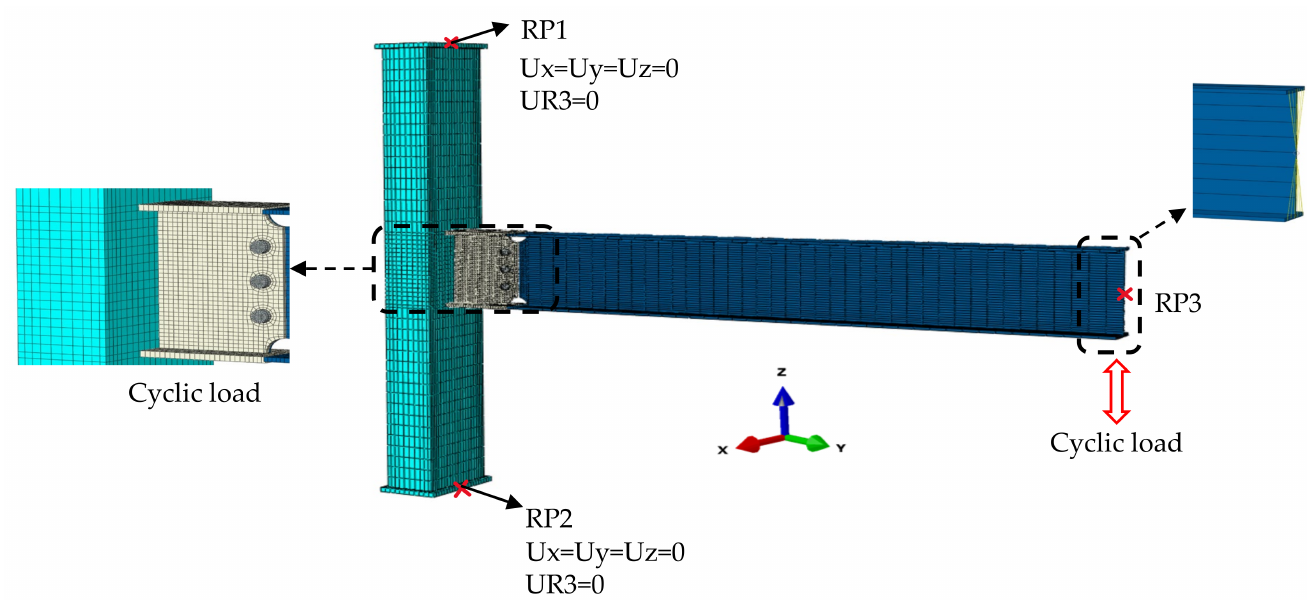
Figure 18. Mesh, boundary conditions and loading details of the